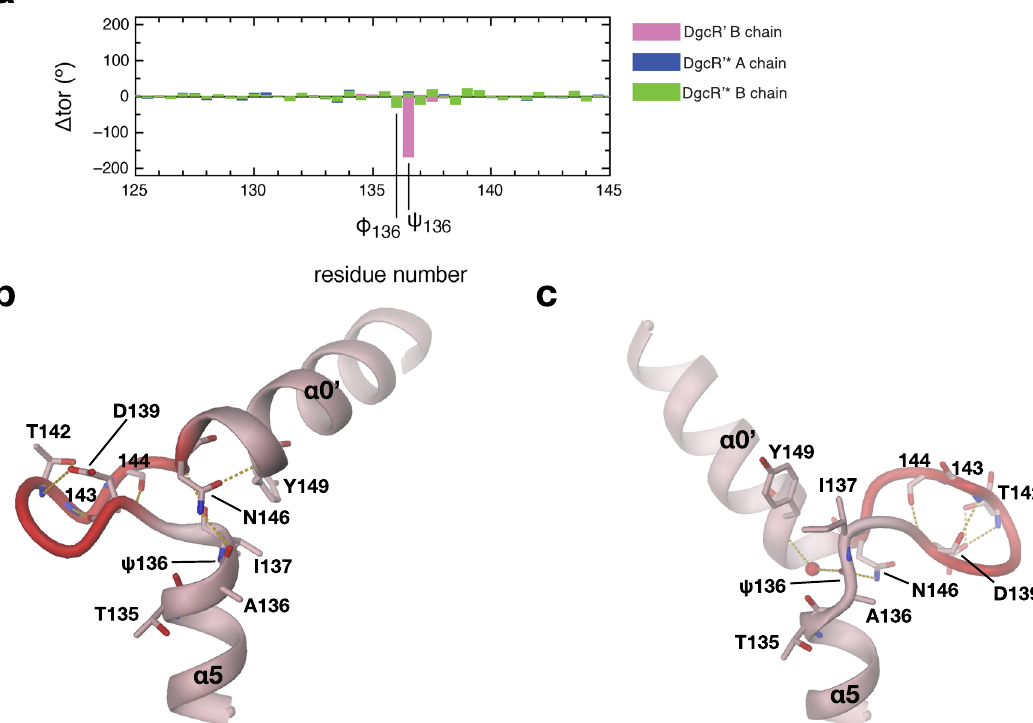
Fig. 2 Inter-domain hinge revealed by comparison of the two DgcR ’ protomers. a Difference of backbone torsion angles ( Δ tor) of DgcR ’ and DgcR ’ * chains relative to chain A of DgcR ’ . Note that the two DgcR ’ chains show a localised drastic difference in the main-chain torsion angle ψ 136. b , c Detailed view of the inter-domain hinge segment of chain A ( b ) and B ( c ) of DgcR ’ . The wide turn with the D139xLT142 motif is highlighted in red. The 169° rotation of ψ 136 drastically changes the relative angle between α 5 of the Rec and α 0 ’ of the GGDEF domain.